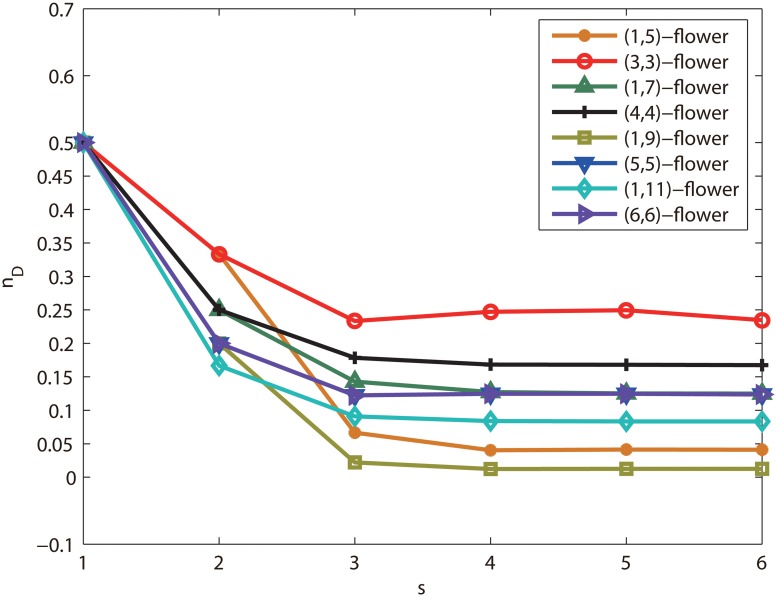
Controllability measure n
D of the (x, y) flower networks at different iteration s.Controllability measure n
D is a function of iteration step s for the (x, y) flower networks, where we take x+y = 6, 8, 10 and 12 respectively. These networks are iterated to step 5. The controllability measure are equal of all networks at s = 0, after start to fall at s > 0, and converges a constant lower than 1 at s > 4.